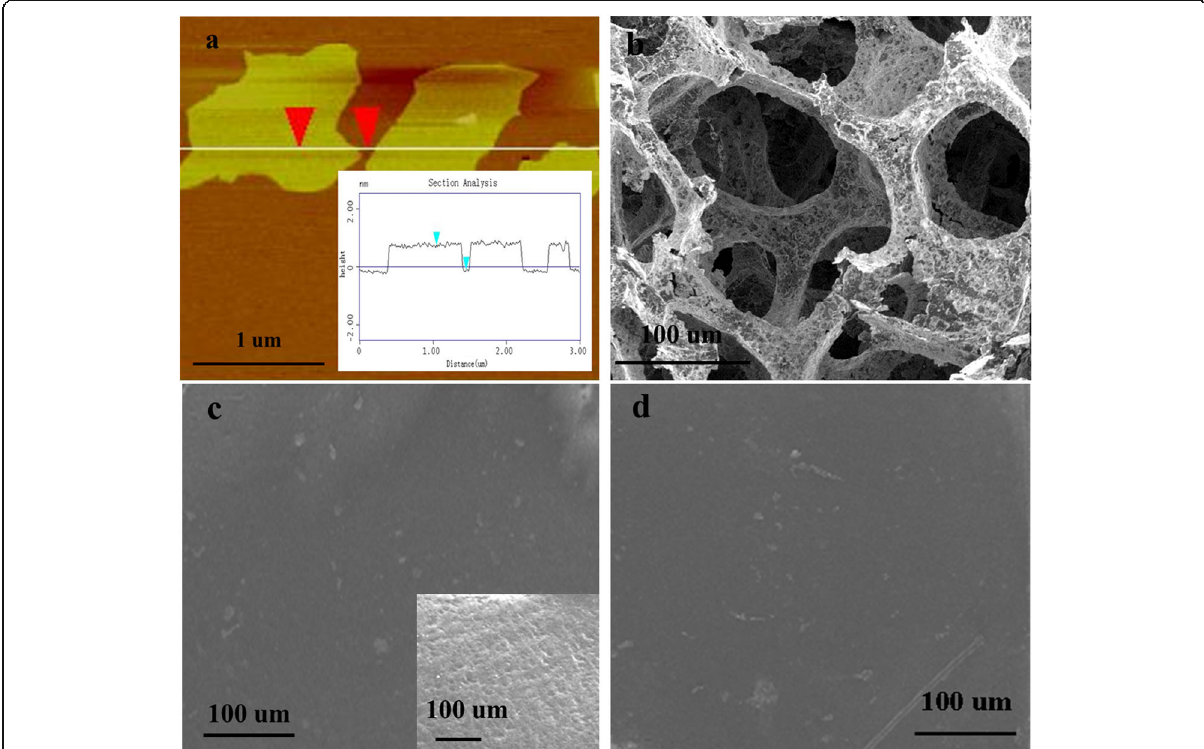
Fig. 1 Morphologies of the RGO nanosheets, 3DGNs, and resulting TIMs. AFM and SEM images of the prepared RGO nanosheets, 3DGNs, RGO-3DGNs, and RGO-3DGNs-ER are shown in Fig. 1. The average size of the RGO nanosheets is 400~600 nm a , which is elaborately designed to combine with the 3DGNs by adjusting the oxidation and reduction procedures. A continuous 3D construction of the 3DGNs can be seen from b , and its porous structure is clearly shown. As for the resulting TIM, the smooth surface of the RGO-ER can be seen from c , and the absence of tiny pores (compared with that of the pristine ER, inset of c indicates a potential high thermal performance. d The morphology of the RGO-3DGNs-ER, which is similar with that of the RGO-ER. The 3D structure of the 3DGNs is difficult to identify in the SEM image because the 3D interspaces are filled by the ER. However, the 3D pho- non transport network (the function of the 3DGNs) still maintains in the TIMs, which has been proven by our previous reports. The RGO nanosheets in the RGO-3DGNs-ER should be loaded on the surface of the 3DGNs because of the hydrothermal reaction, which is the pre-condition to exert the func- tion (enhance the wettability between the graphene basal plane and ER) of the RGO